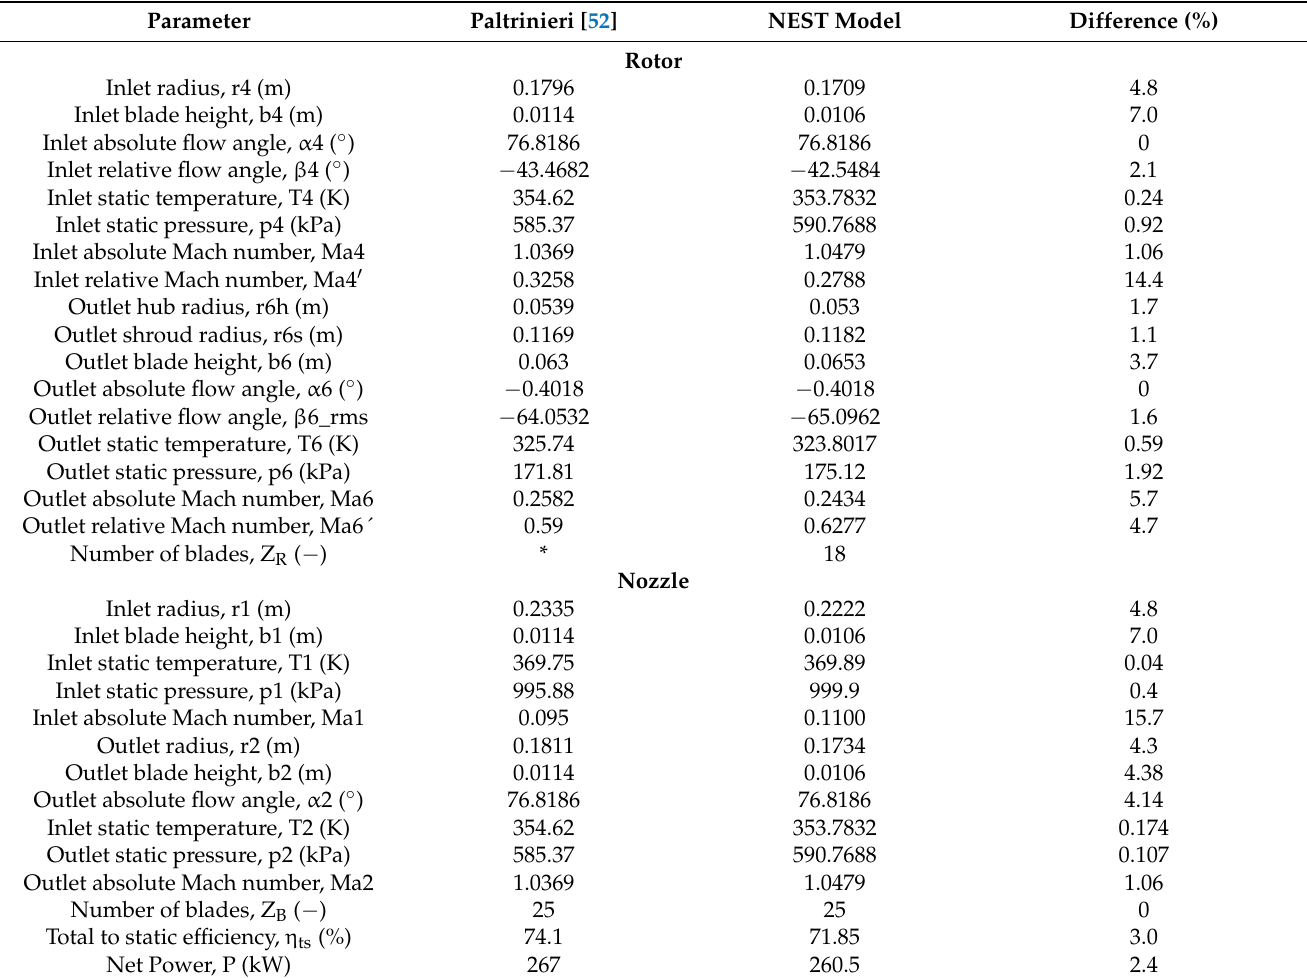
Table 2. Parameters compared in the validation of the radial